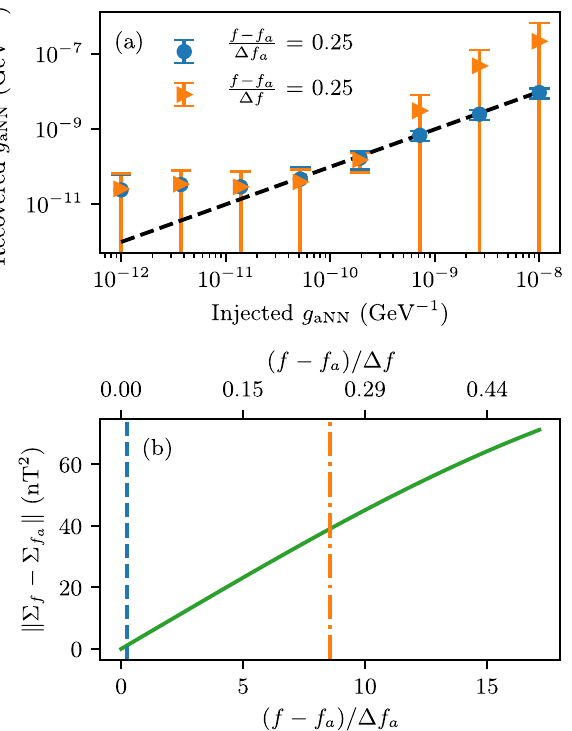
FIG. 15. (a) Signal injection and recovery plots for the case when the test frequency f does not equal the true axion frequency f . The blue marker shows the case when f is a quarter of the a axion linewidth Δ f away from the true axion frequency, while a the orange marker shows the case when f is misaligned by a quarter of the frequency grid spacing Δ f . We present here for Δ f ≪ Δ f . (b) Frobenius norm of the difference between the test a covariance matrix Σ and the true axion covariance matrix Σ f The blue dashed vertical line corresponds to the legend of the blue marker in (a) while the orange dash-dot vertical line corresponds to the legend of the orange marker in